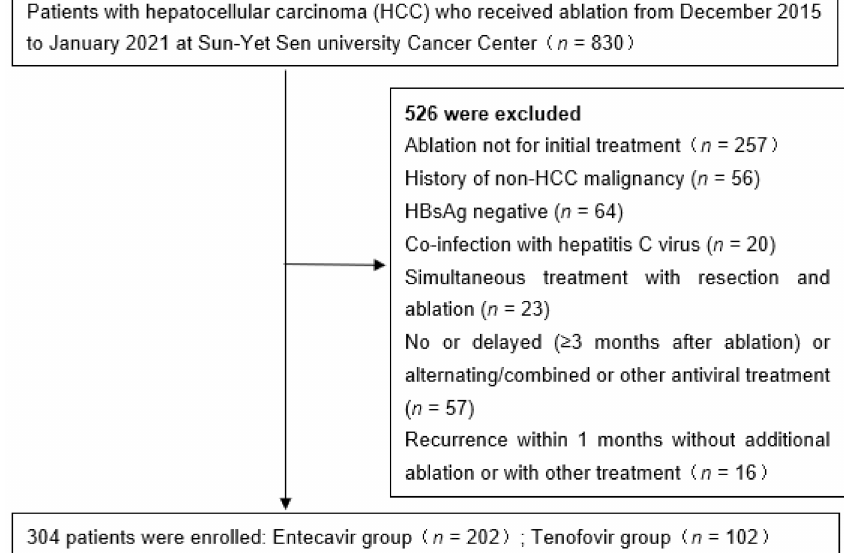
Figure 1. Flow diagram of enrolled